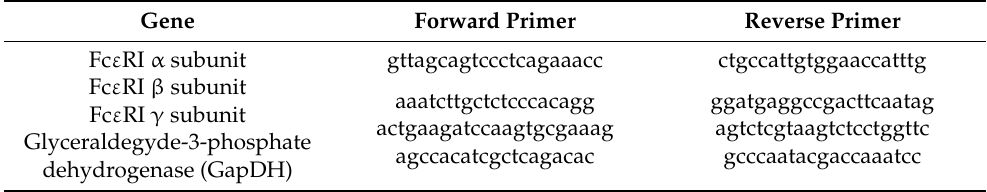
Table 1. List of intron spanning human oligonucleotide primers used in this